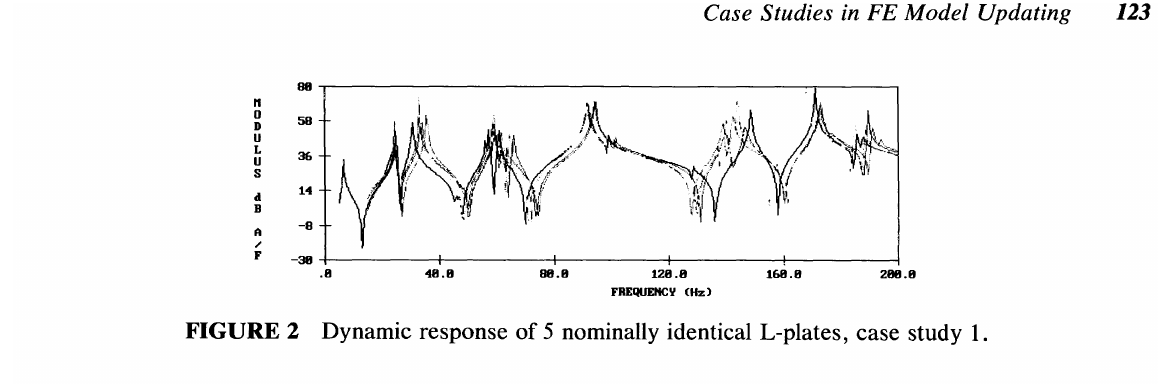
FIGURE 2 Dynamic response of 5 nominally identical L-plates, case study 1.